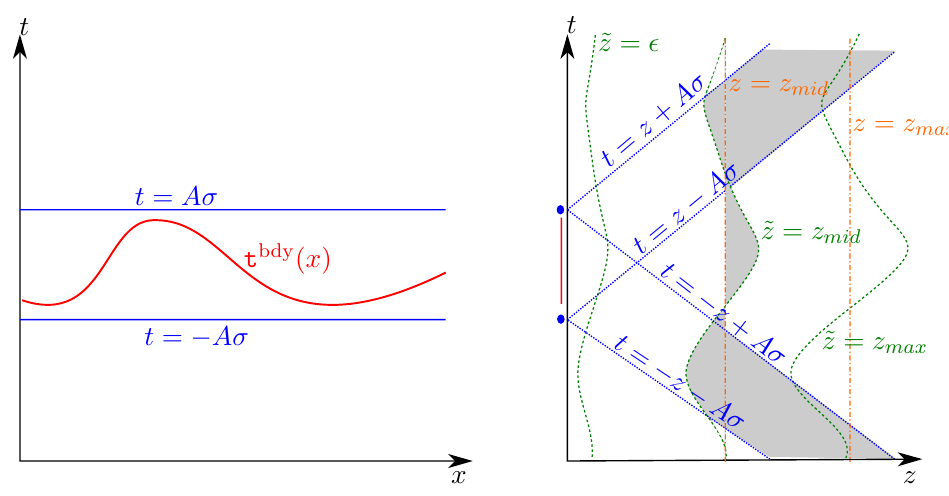
Figure 4 . Bounds relevant for the calculation of the bulk integral, not to scale. Left: asymptotic boundary. Right: a x = const : slice of the bulk, in Poincar(cid:19)e-patch coordinates of